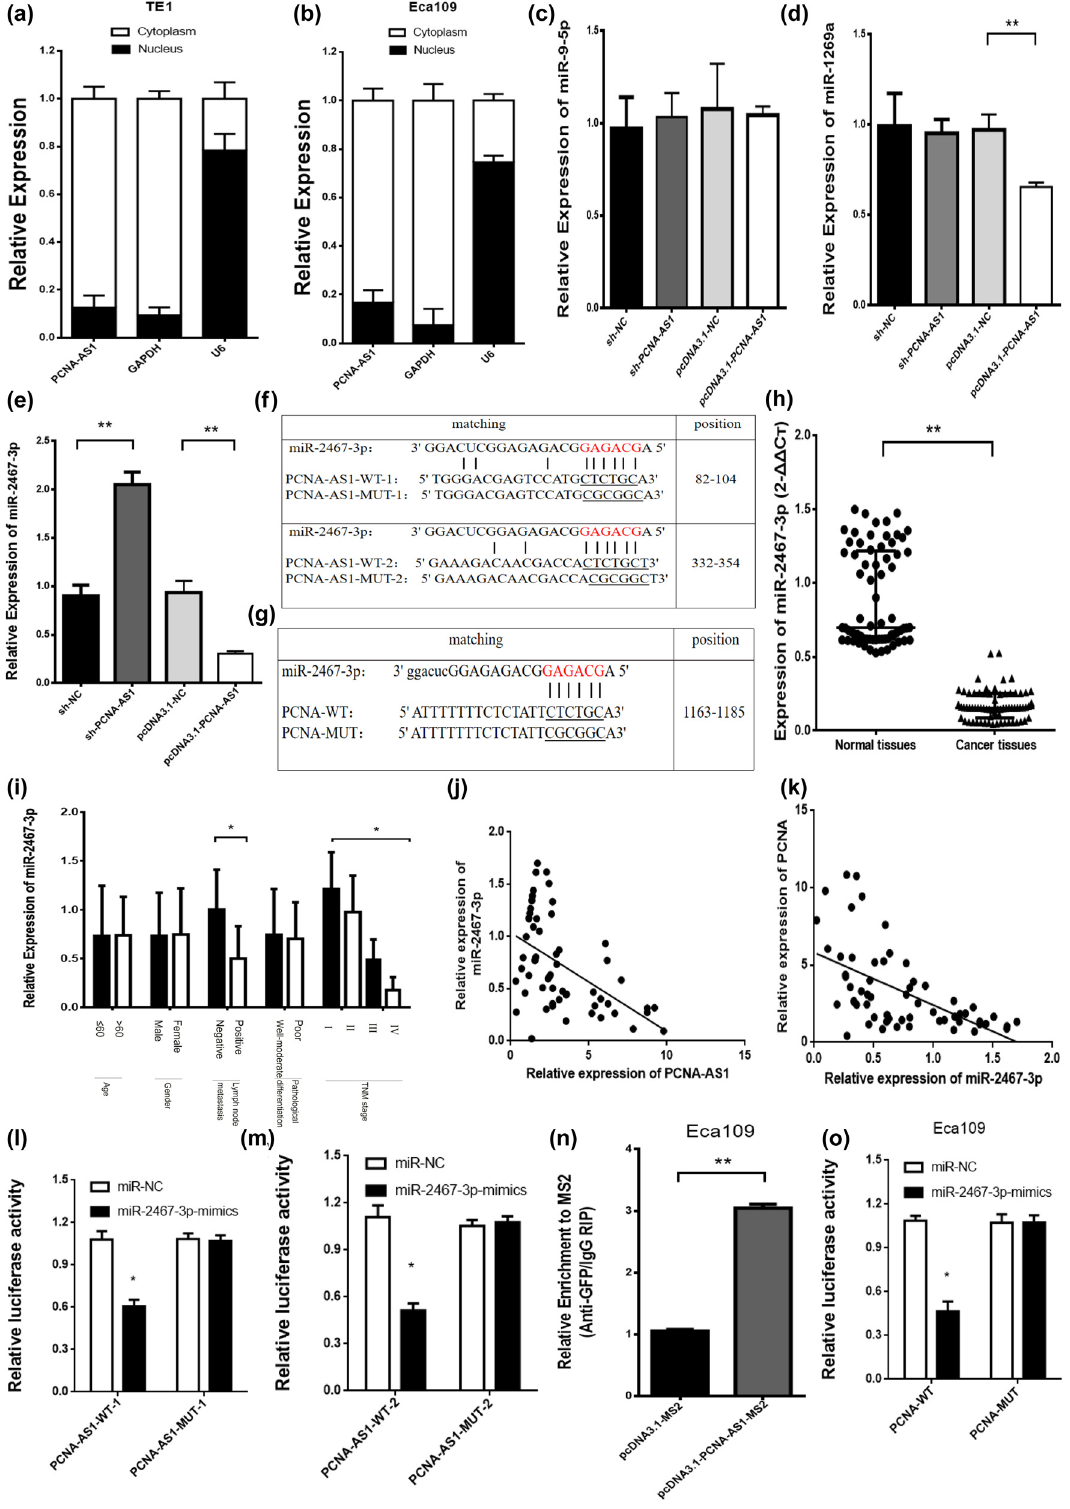
Figure 4: miR - 2467 - 3p includes binding sites to PCNA - AS1/PCNA and is negatively associated with PCNA - AS1/PCNA. ( a and b ) The dis - tribution of PCNA - AS1 in TE1 and Eca109 cells. ( c – e ) E ff ects of PCNA - AS1 on downstream target miRNA. ( f and g ) The wild - type and mutated ( mutant ) PCNA - AS1/PCNA binding sites to miR - 2467 - 3p. ( h ) miR - 2467 - 3p was less expressed in ESCC tissues than in normal tissues. ( i ) The relative expression of miR - 2467 - 3p was correlated with the TNM stage and lymph node metastasis. ( j and k ) The correlation of miR - 2467 - 3p and PCNA - AS1 or PCNA. ( l and m ) Dual luciferase reporter assay to verify the binding activity between PCNA - AS1 and miR - 2467 - 3p. ( n ) RIP assay showing the high enrichment of PCNA - AS1 by miR - 2467 - 3p. ( o ) Dual luciferase reporter assay to verify the binding activity between PCNA - AS1 and miR - 2467 - 3p. *P < 0.05 and **P <